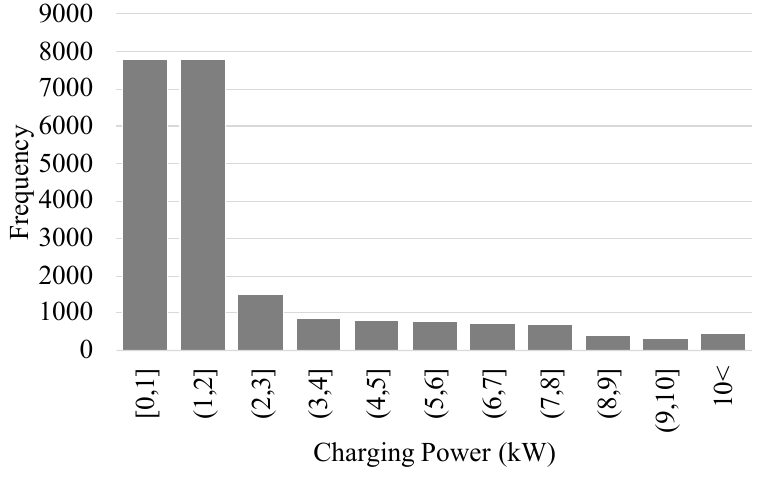
Figure 3. Histogram of actual charging power used by the electric and hybrid vehicle